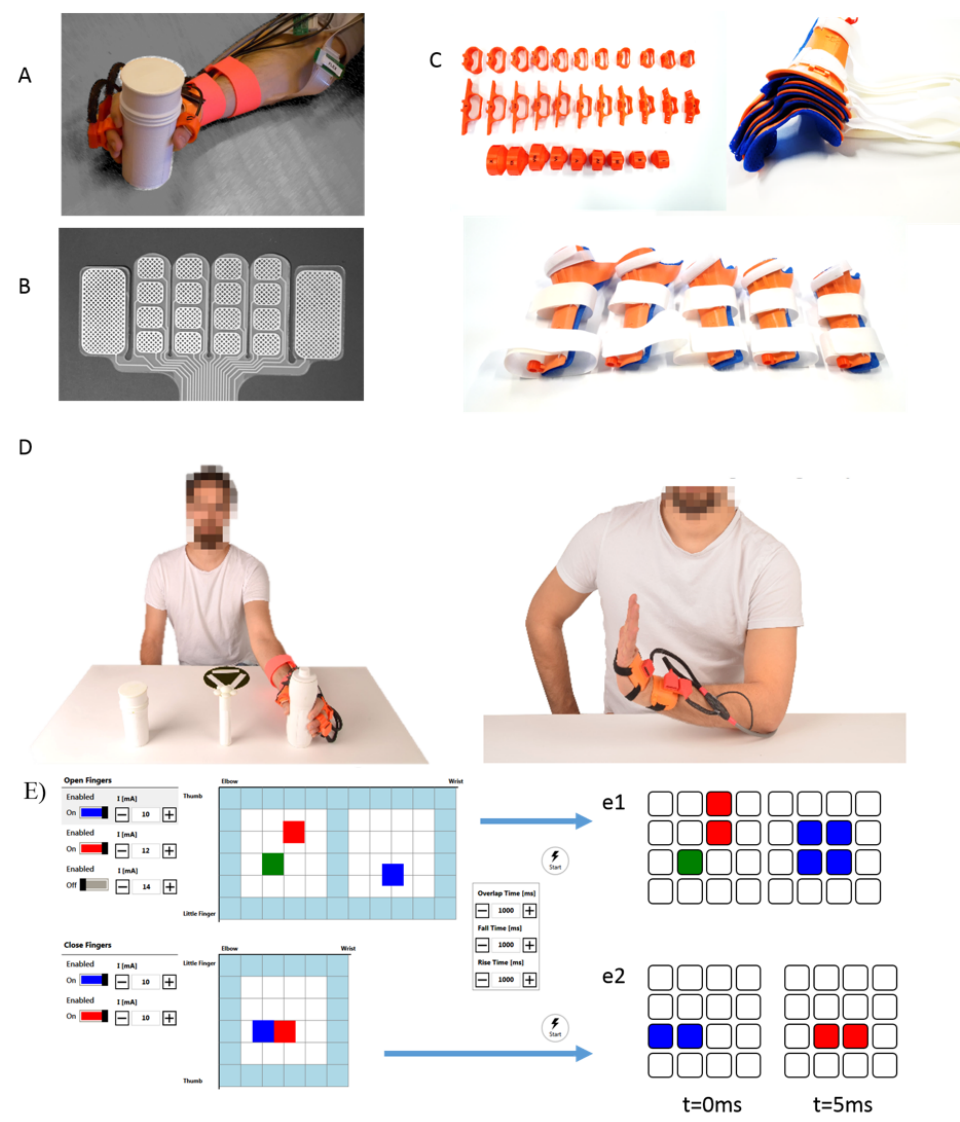
Figure 2. Wearable NMES system. The wearable system consists of units aimed at providing NMES, at constraining hand and wrist, and at sensing environmental interaction. Panel ( A ) The orthosis constrains the dorsal aspect of hand and wrist, and hosts the RF antenna between thumb and index to improve reliability and repeatability of object detection. A soft ring constrains the thumb in opposition and includes a force sensor for assessing localised contact force. Panel ( B ) Electrode arrays used for the trials. Panel ( C ) Anthropometric variability is accounted for by design. The rigid wrist-constraining orthoses are designed in five sizes and, if warmed, can be adapted to patient- specific ergonomic needs. Rings, proximal clasp, and distal clasps are soft and produced with a larger variability. Panel ( D ) Visual and auditory cues in the GUI precede the desired exercise execution. Panel ( E ) Stimulation maps are defined by virtual electrodes location and intensity of stimulation. Virtual Electrodes(VEs) can be enabled alone or combined, to fine tune the desired motor